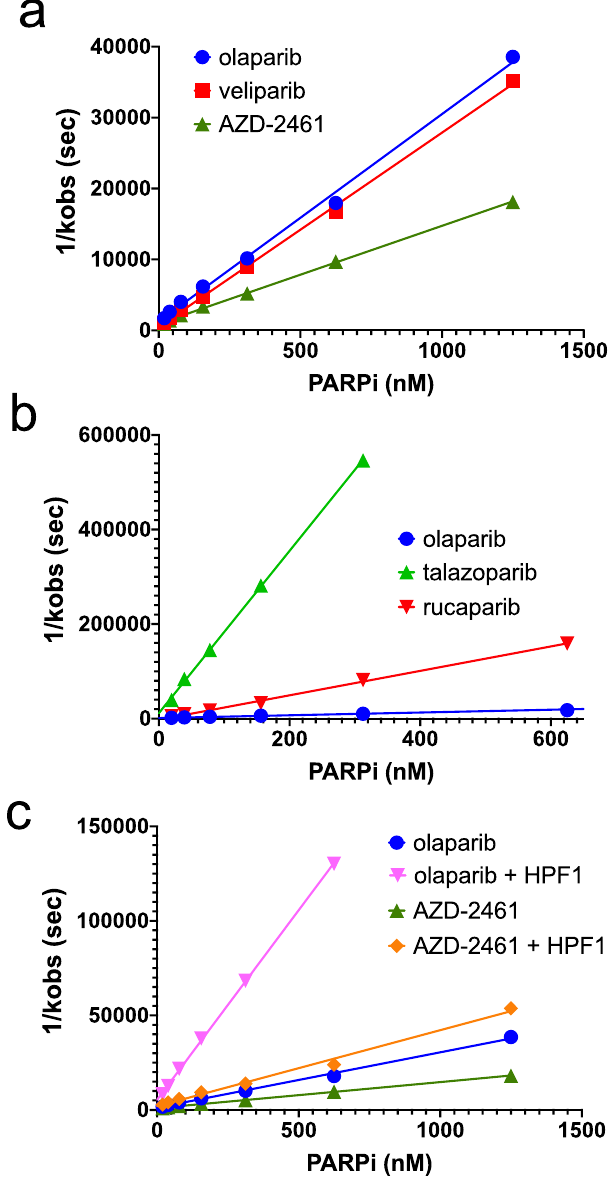
Fig. 2 Representative replots for the data collected in Fig. 1 after linearization. a The similar potencies for olaparib vs. veliparib are readily apparent from the nearly identical slopes of the lines. In contrast, AZD- 2461 is a less potent inhibitor of PARP1. b Comparison of the more potent inhibitors talazoparib and rucaparib vs. olaparib. Note the much steeper slopes and change in scale of the y -axis compared to ( a ). The data for olaparib in this plot are a duplicate from ( a ) to facilitate direct comparison. c The effect of HPF1 on inhibitor potency is readily seen for both olaparib and AZD-2461. The data for olaparib in this plot are a duplicate from ( a ) to facilitate direct comparison. A complete list of derived K I from these replots and multiple replicates are shown in Table